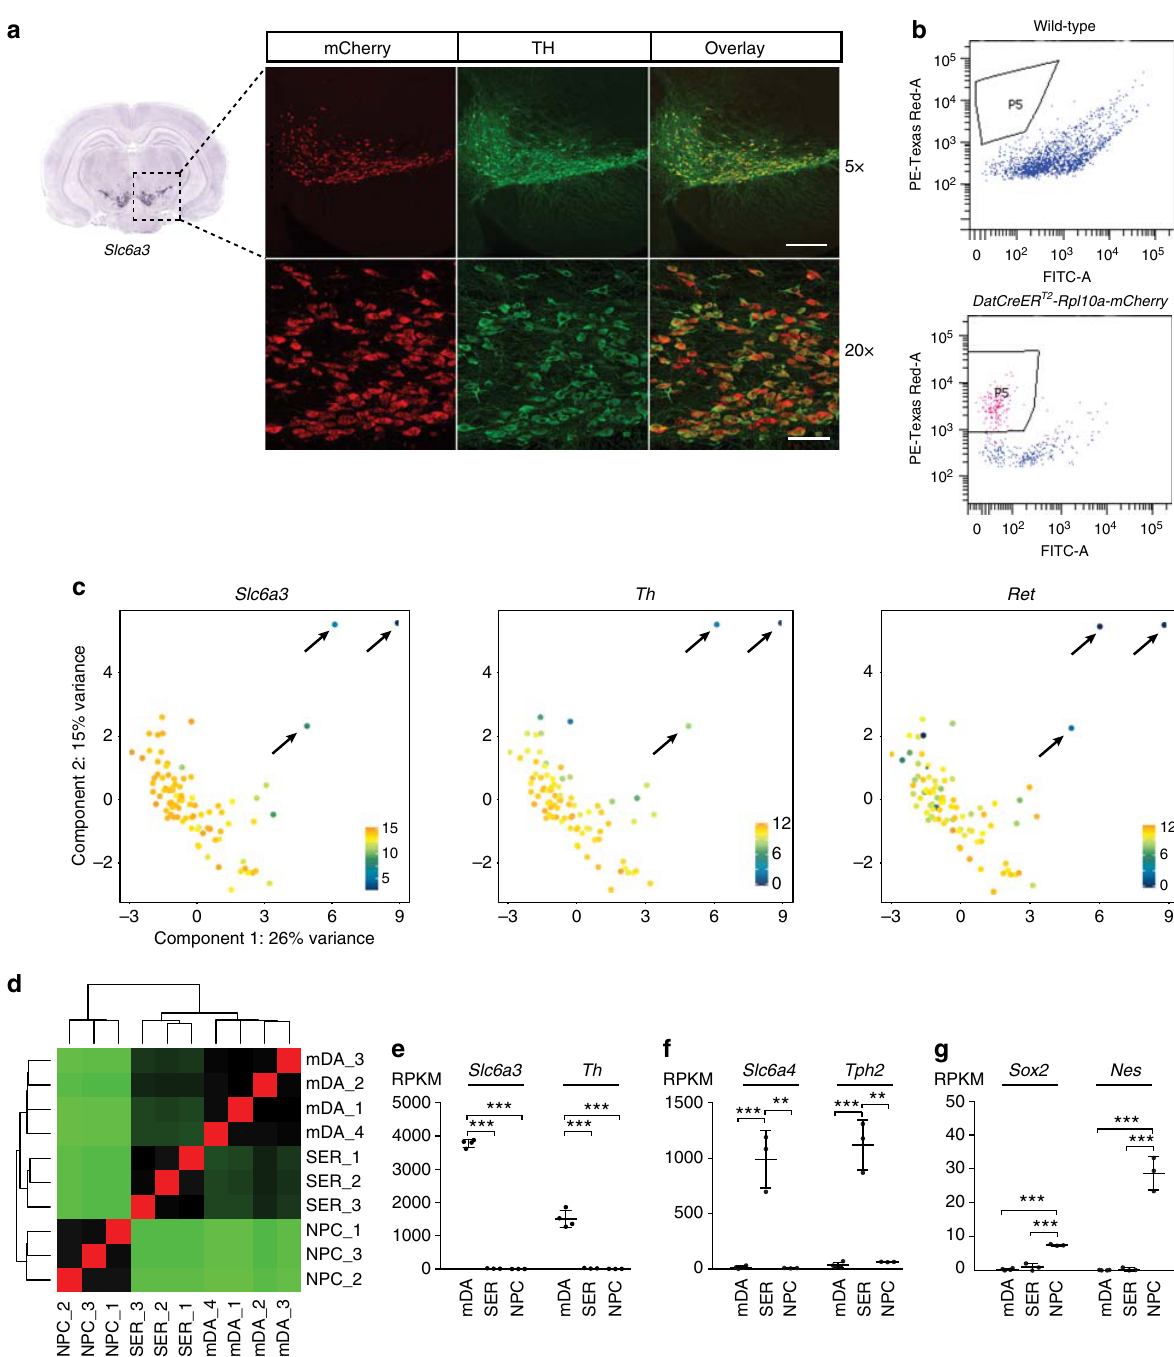
Fig. 1 Puri fi cation of adult neuronal and neural progenitor nuclei. a Rpl10a-mCherry expression (red) overlaps TH (green) expression in the ventral midbrain in DatCreER T2 - Rpl10a - mCherry mice. 5x and 20x magni fi cation. To the left is an in situ hybridization for Slc6a3 taken from the Allen Brain Atlas (mouse. brain-map.org, image credit: Allen Institute), indicating the position of the images. Scale bars: 200 μ m (upper panels), 50 μ m (lower panels). b FACS plots showing a population of nuclei, indicated by “ P5, ” occurring in DatCreER T2 - Rpl10a - mCherry mice but not in wild-type mice. Single-nuclei RNA-seq: c PCA- plots constructed from normalized single-nuclei log-expression values of correlated HVGs. Each nucleus is colored according to the expression of Slc6a3 , Th , or Ret . Arrows indicate three outlier nuclei identi fi ed as originating from non-mDA neurons. A total of 1000 nuclei bulk RNA-seq: d Heatmap showing sample-to-sample distances between hierarchically clustered mDA, SER, and NPC RNA-seq libraries. e Expression of dopaminergic neuron markers is restricted to mDA nuclei: bars indicate average RPKM ± SD for Slc6a3 and Th as RPKMs in mDA ( n = 4 mice), SER ( n = 3 mice), and NPC nuclei ( n = 3 embryos). f Expression of serotonergic markers is restricted to SER nuclei: bars indicate average RPKM ± SD for Slc6a4 and Tph2 as RPKMs in mDA, SER, and NPC nuclei. g Expression of neural progenitor markers is restricted to NPC nuclei: bars indicate average RPKM ± SD for Sox2 and Nes as RPKMs in mDA, SER, and NPC nuclei. Signi fi cance for e – g according to two-tailed Student ’ s t -test assuming equal variances. *** p ≤ 0.001, ** p ≤